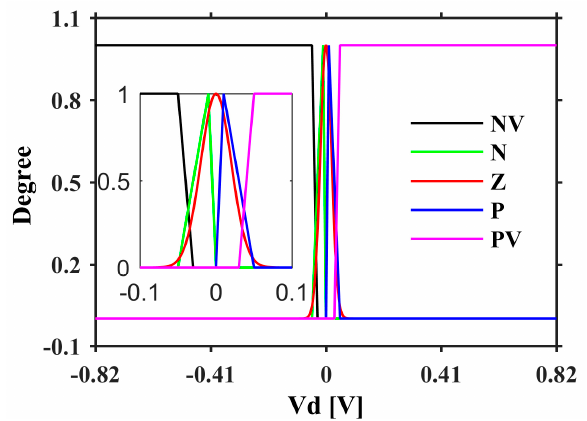
Figure 8. Membership function of OCV differences.